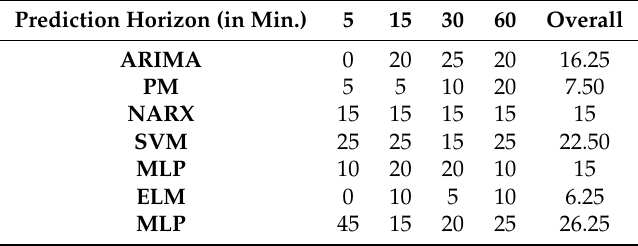
Table 5. Percentages of best performance of state-of-the-art methods for different prediction horizons. Prediction Horizon (in